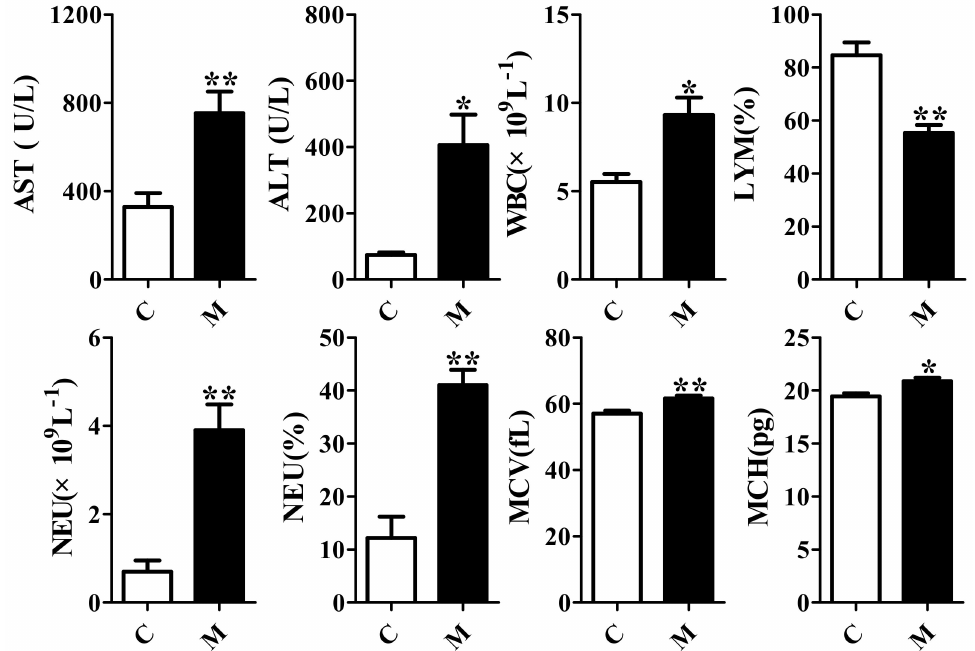
Figure 1. Changes in alanine aminotransferase (ALT), aspartate aminotransferase (AST), and peripheral blood routine between control group (C) and model group of acute liver injury (M). WBC: white blood cell count, LYM: lymphocyte ratio, NEU: neutrophil count/ratio, MCV: erythrocyte mean corpuscular volume, MCH: mean corpuscular hemoglobin (means ± SEM, n = 6, * p < 0.05, ** p < 0.01 vs. control group).